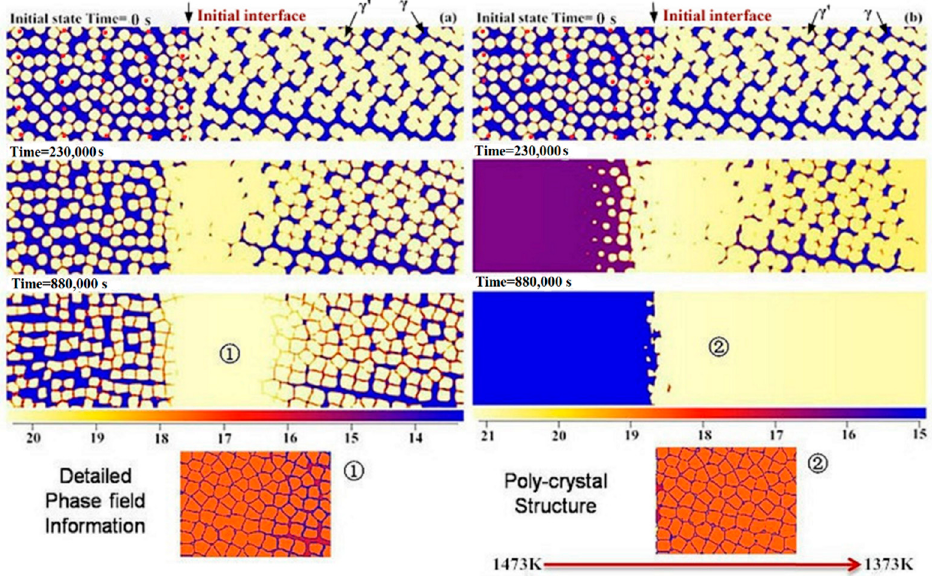
Figure 5. Phase-field simulated microstructure evolution of No. 1 γ + γ '/ γ + γ ' bond coat/substrate system (Ni–18at.%Al–12at.%Cr/Ni–19at.%Al–5at.%Cr) annealed ( a ) at 1373 K and ( b ) with an effect of temperature gradient Δ G = 5000 K/cm. The color bar scale indicates the mole fraction of Al in atom percent.